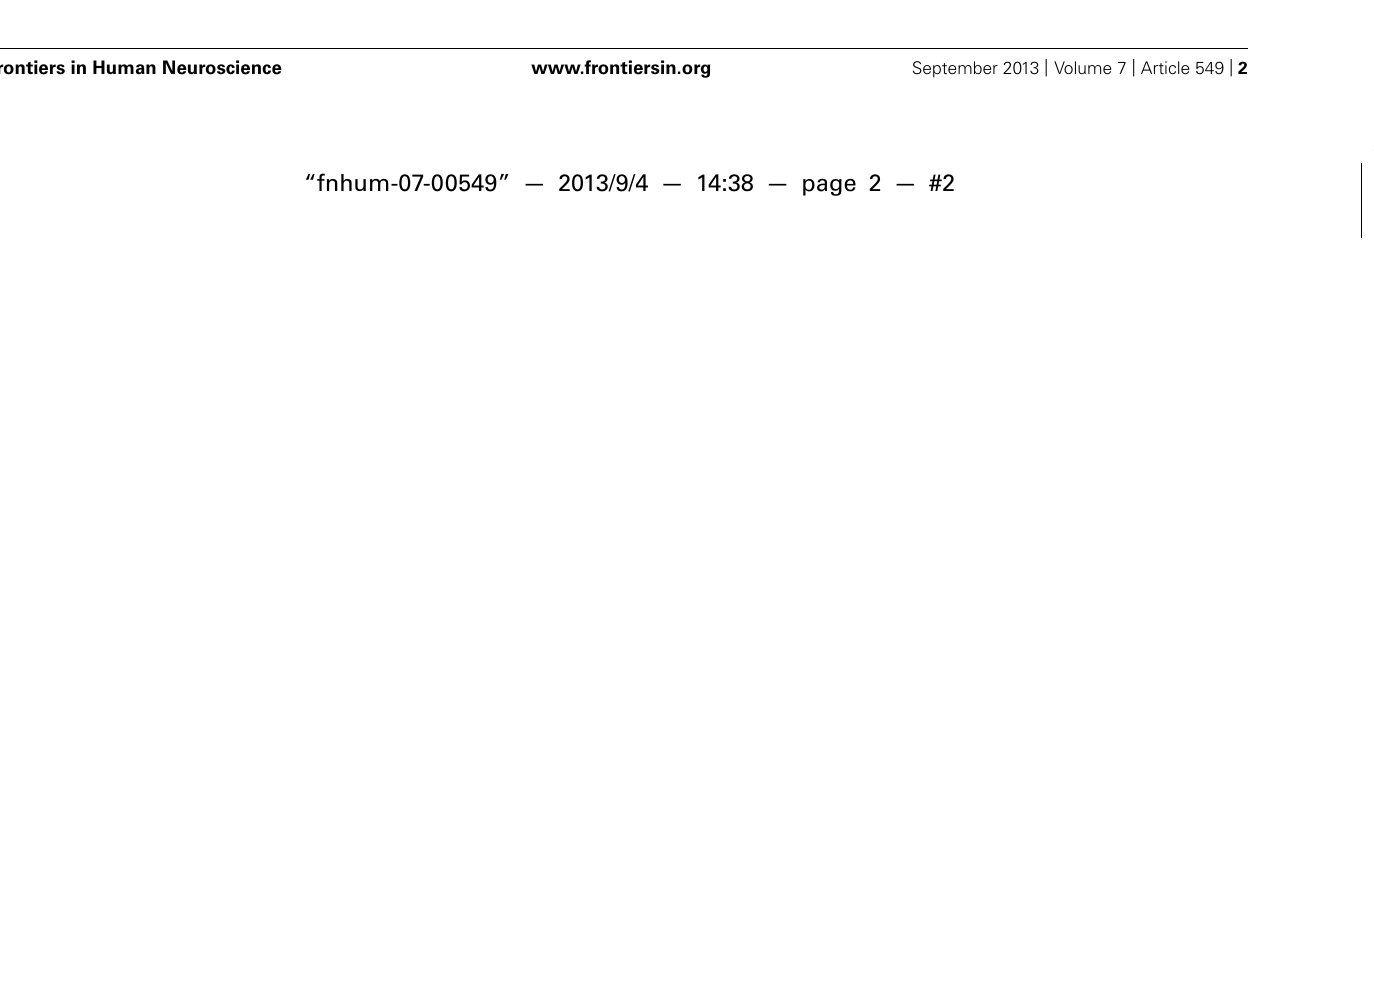
FIGURE 1 | Examples of OBT-stimuli. The task of the observer is to decide whether the figure’s left or right hand is highlighted by a critical feature (green or red disc), and to press a corresponding left- or right-hand key.Various stimuli and features (e.g., human or abstract figures, gloved hand, ball or disc in hand) are used in actual experiments. Left side: Different upright figure stimuli ( A and B ) with compatible (tick mark) and incompatible (cross) correct responses. Right side: Different figures with rotations of 30° and 180° in the picture plane ( C and D ) with compatible (tick mark) and incompatible (cross) correct responses. Only figures with the critical feature on the figure’s left hand are shown; compatibilities are the same for features on the figure’s right